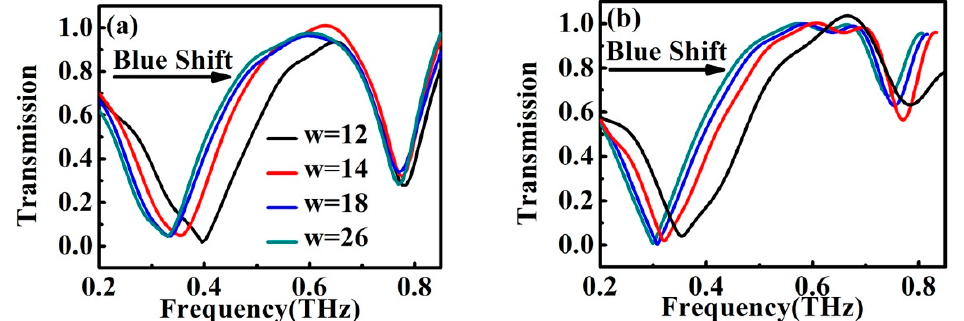
Figure A1. Experimental ( a ) and simulated ( b ) amplitude transmission spectra for samples with different value of w, when the E field is parallel to x-axis.